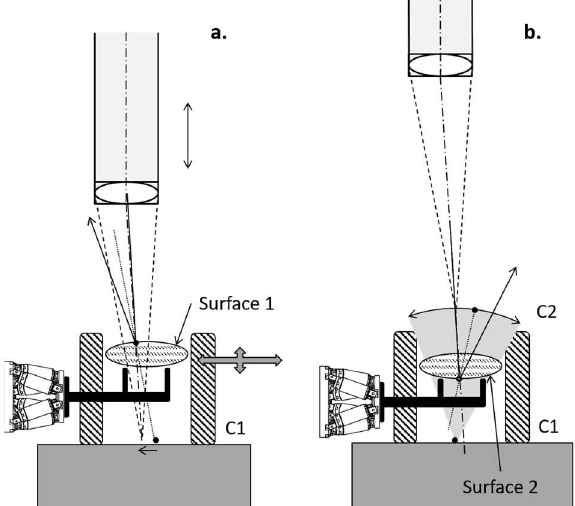
Fig. 2. Alignment of the lens with respect to the autocollimator. Left: lateral adjustment of the lens to move the first center of curvature C1 to the reference axis. Right: tilt of the lens to adjust surface 2, such that C1 is unchanged. Note that the mount position is not changed.